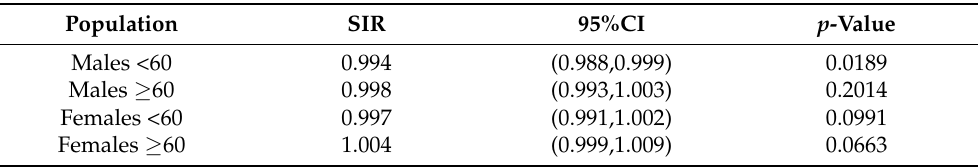
Table 2. SIRs of the effect of the agricultural population on the risk for cutaneous MM in age groups (<60 and ≥ 60) in males and females in Upper Silesia, Poland (2004–2013). Population SIR 95%CI p -Value Males <60